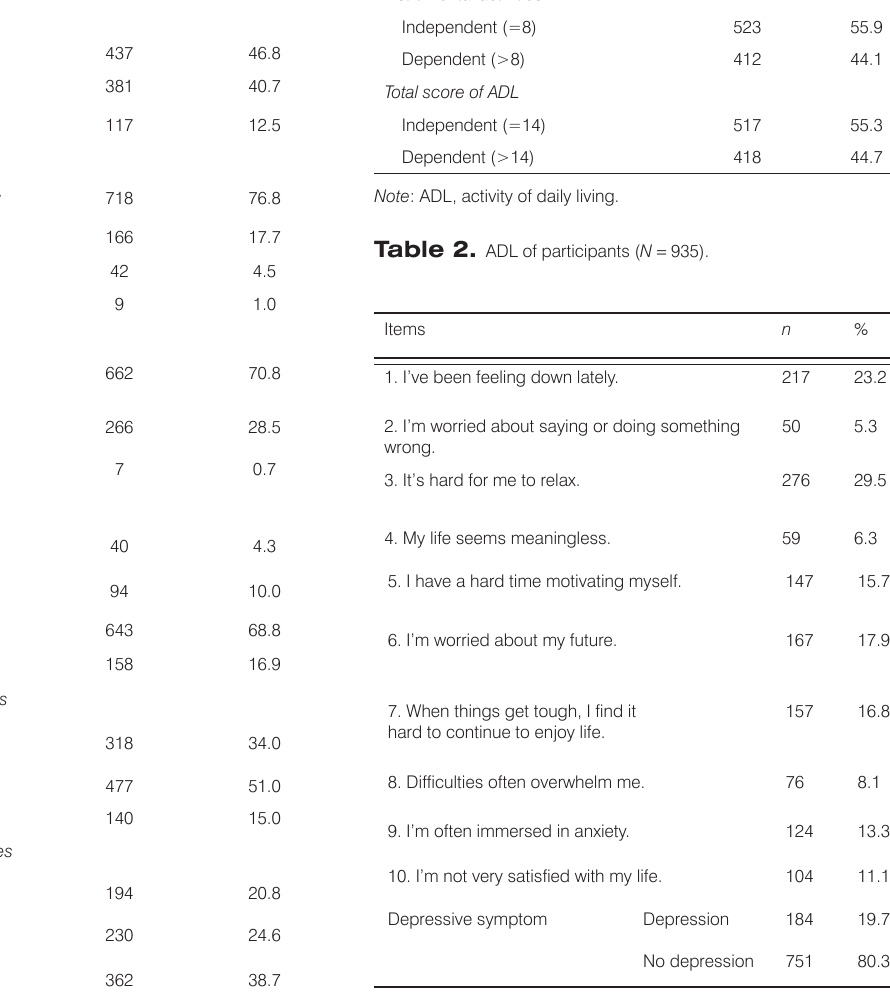
Table 3. Selection of items for symptoms of depression ( N =